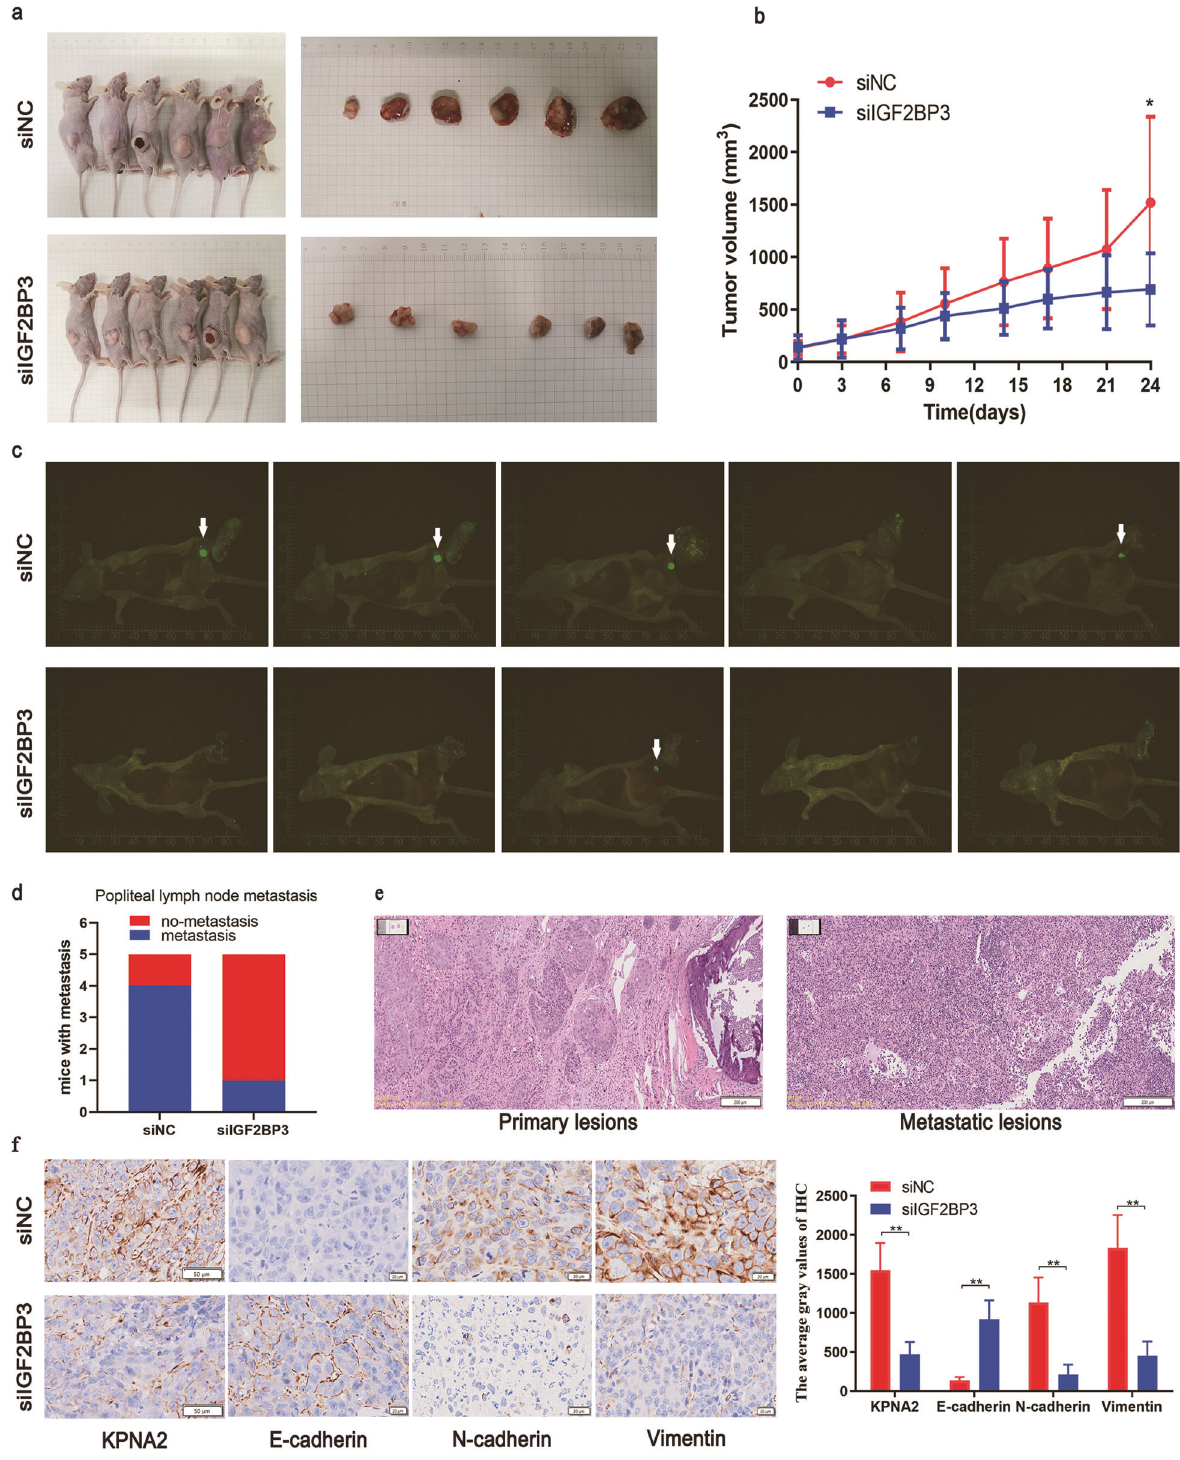
Fig. 6 IGF2BP3 suppressed proliferation and metastasis in vivo. a Tumors formed by subcutaneous injection of 5 – 8 F cells transfected with siNC or siIGF2BP3 into nude mice. b The growth curves of tumor volumes were depicted in the siNC and siIGF2BP3 groups. c Metastatic popliteal lymph nodes were visualized by fl uorescent staining. d The incidence of popliteal lymph node metastasis of each group. e HE staining of popliteal metastasis. f The expression of KPNA2, E-cadherin, N-cadherin and Vimentin in tumors assessed by IHC. Data was shown as the mean ± standard deviation of three independent experiments. * P < 0.05, ** P < 0.01.